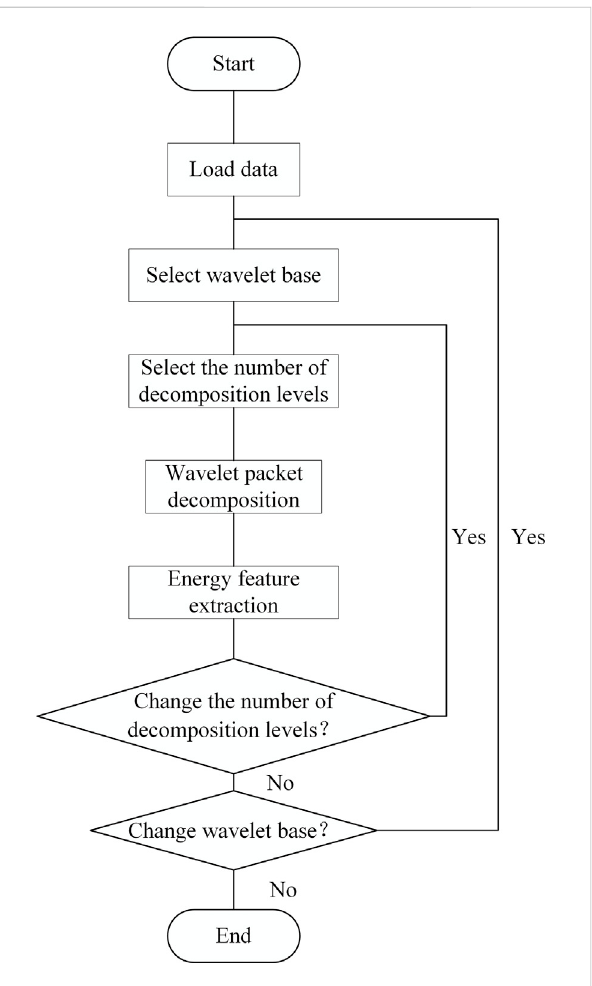
FIGURE 5 Flow chart for extracting characteristic parameters of wavelet packet energy spectrum of transformer sound